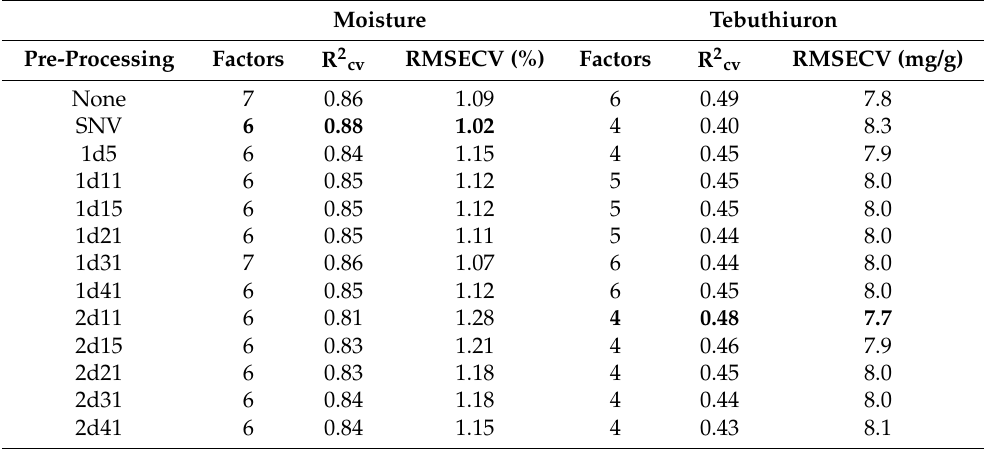
Table 8. Optimum pre-processing methods for the prediction of moisture and tebuthiuron content in powdered Regain samples using the benchtop Antaris NIR instrument. The best-performing model for each analyte is highlighted in bold.